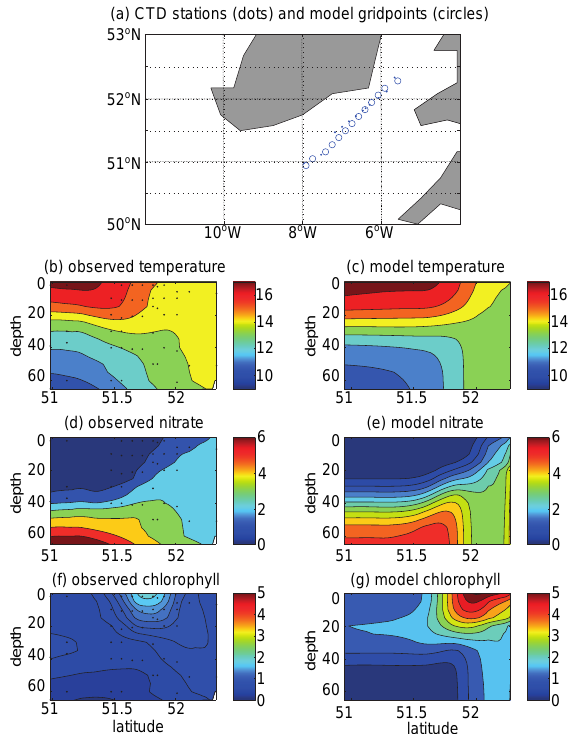
Figure 4. Sections through the Celtic Sea front around day 215 of 2003: (a) locations of CTD stations (dots) and model grid points (circles); (b , c) observed and modelled temperature ( ◦ C); (d , e) observed and modelled dissolved inorganic nitrate (units mmolm − 3 ) ; (f , g) observed and modelled chl a concentration (units mgchl a m − 3 ) . The locations of observations in profile are indi- cated by dots in (b) , (d) and (f) .